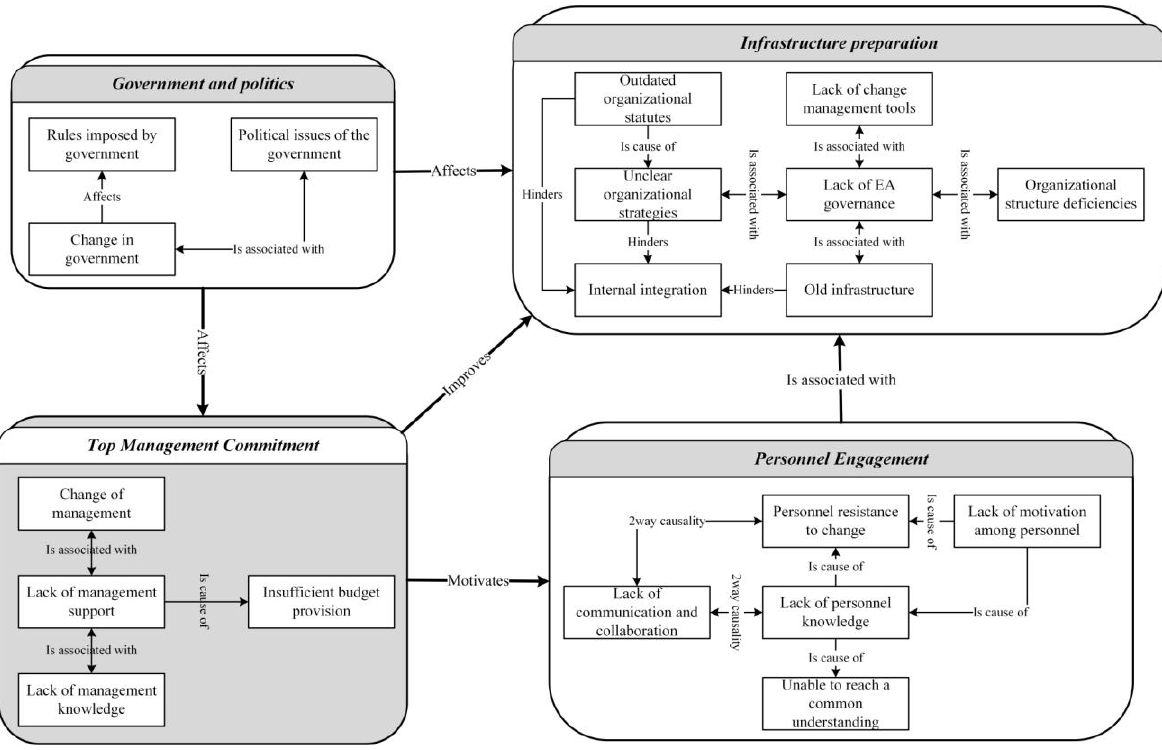
Figure 5. Investigating the relationships between the core category and other